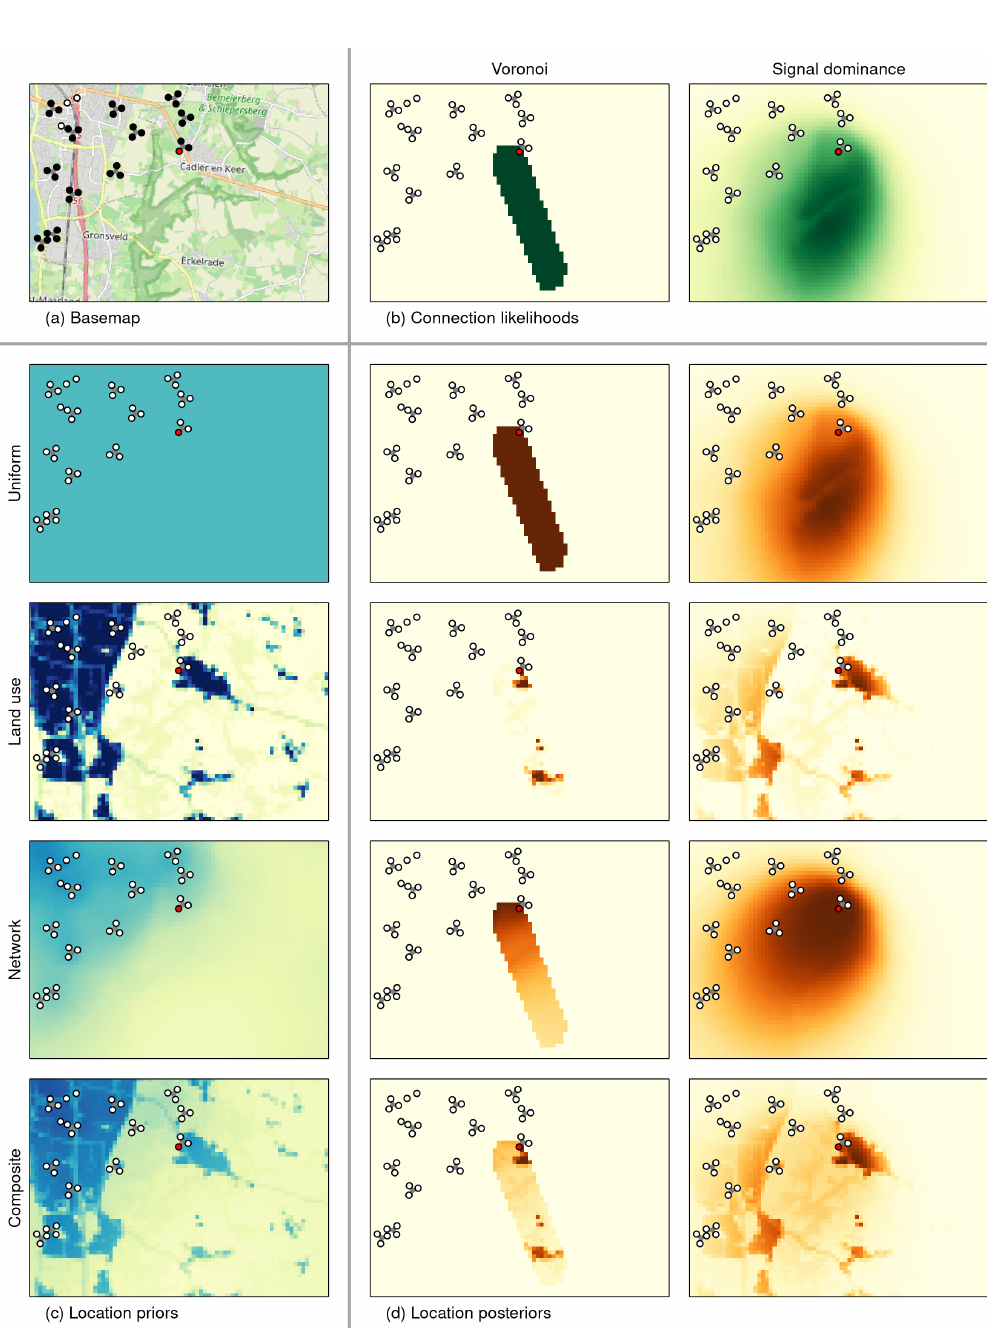
Figure 10: Example showing how three location priors and two connection likelihoods are combined into six location